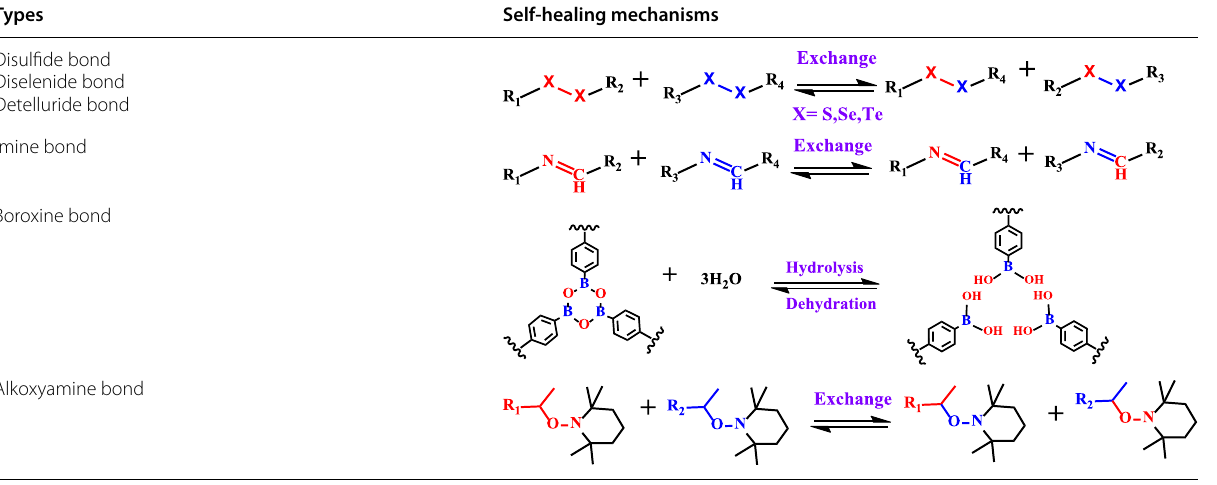
Table 1 Types and self-healing mechanisms of main dynamic covalent bonds for room temperature self-healing polyurethanes